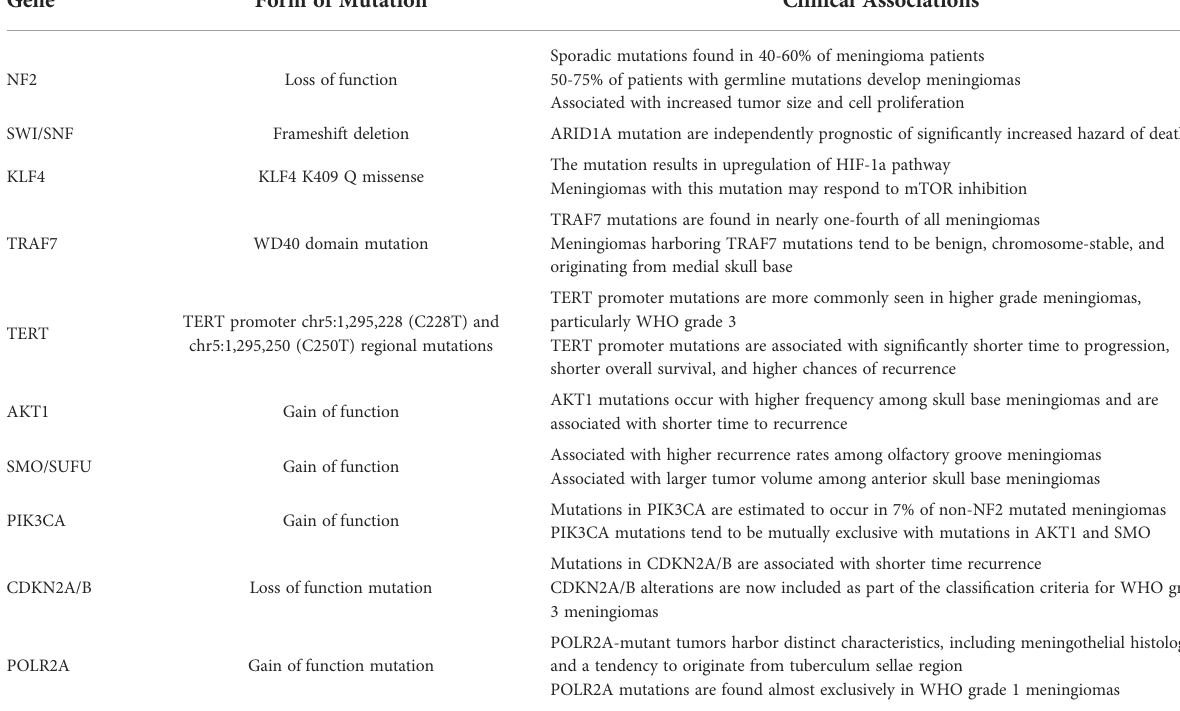
TABLE 1 Commonly identi fi ed germline and somatic mutations in meningiomas.